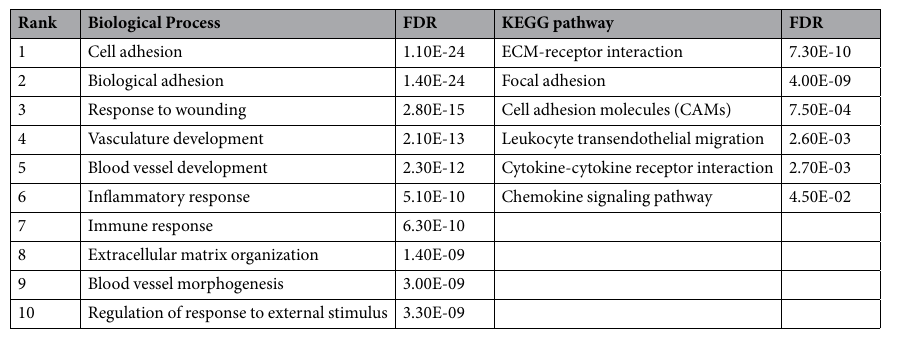
Table 3. Top 10 significant GO BP terms and KEGG pathways enriched with DEGs in